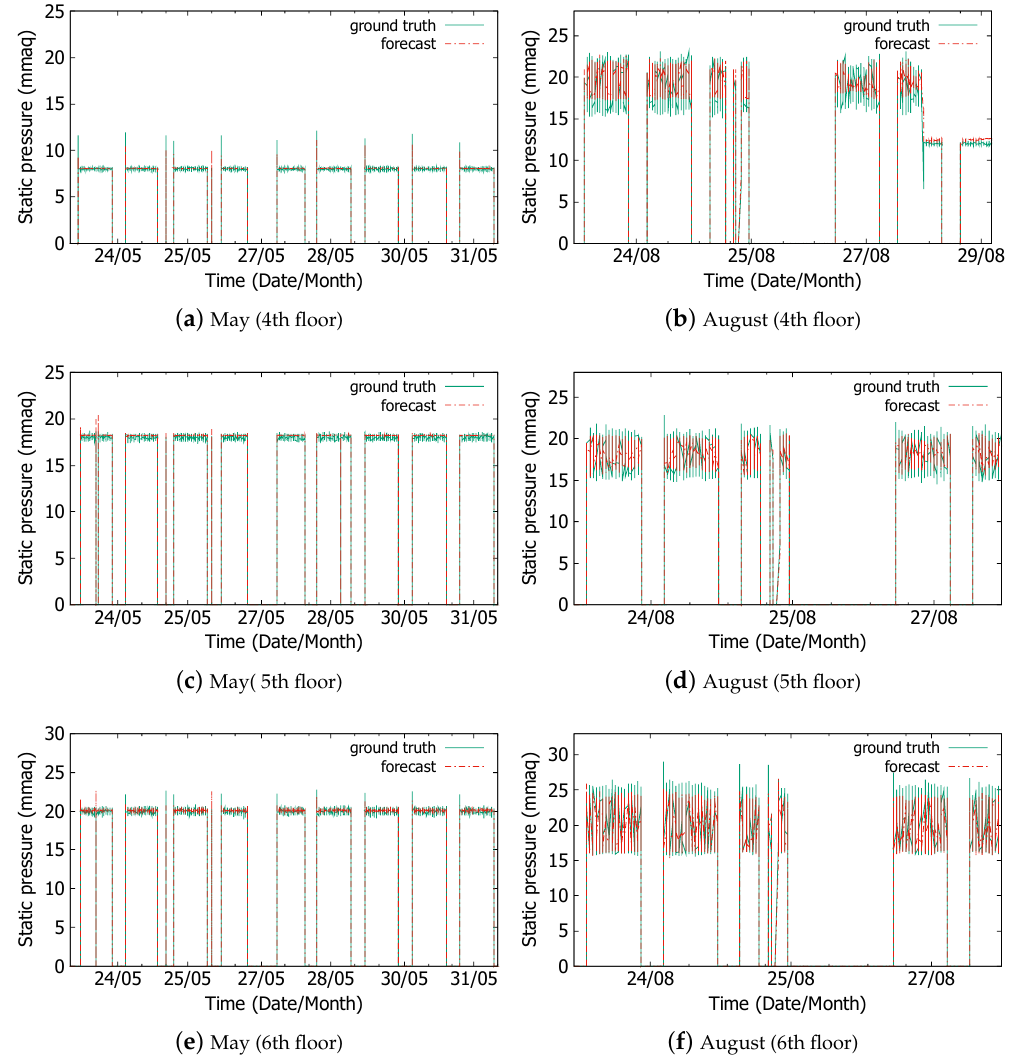
Figure 14. Forecast results for May and August of each floor.